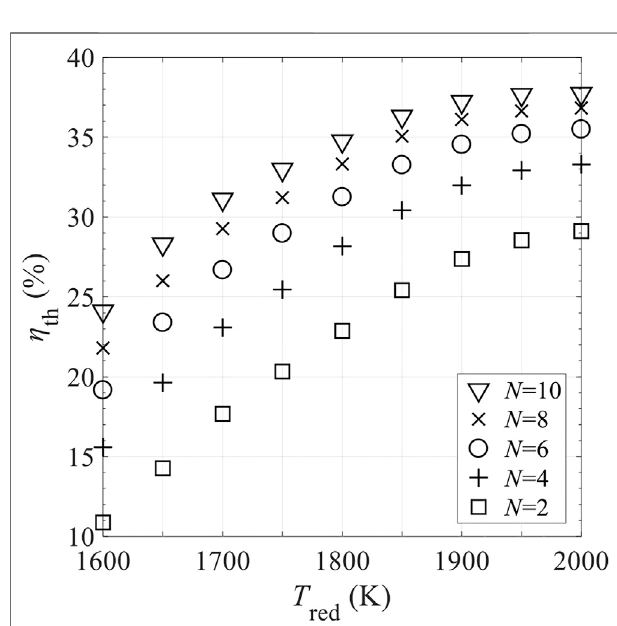
FIGURE 16 | Effect of concentration ratio C on total solar-to-fuel ef fi ciency η th indifferentlevelsofreductiontemperature, T red ,withperfectgas- phase heat recovery and relative oxygen partial pressure p O